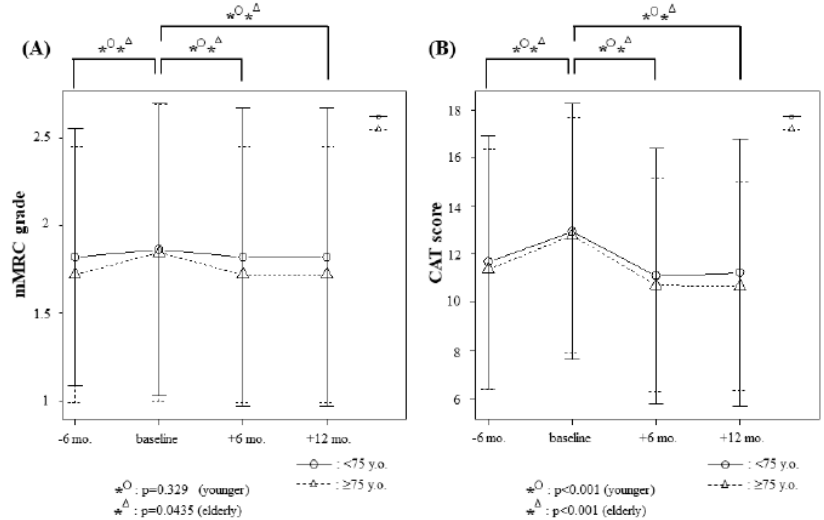
Figure 2. Changes in modified medical research council (mMRC) grade and COPD assessment test (CAT) score 6 months prior to baseline, at baseline, and 6 and 12 months after initiation of nintedanib treatment. In the 32 elderly patients ( ≥ 75 y.o.), the mean mMRC grades at each time point ( A ) were 1.72 (standard deviation [SD]; 0.73), 1.84 (SD; 0.85), 1.72 (SD; 0.73), and 1.72 (SD; 0.73), respectively. The mean CAT scores at each point ( B ) were 11.38 (SD; 4.99), 12.78 (SD; 4.91), 10.72 (SD; 4.43), and